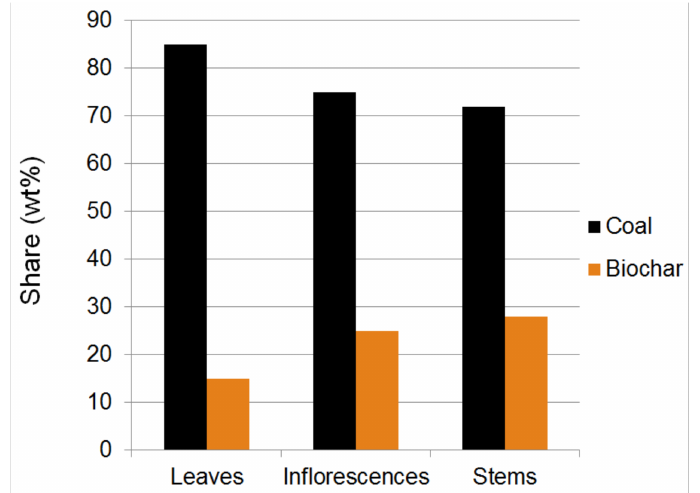
Figure 8. Composite fuel